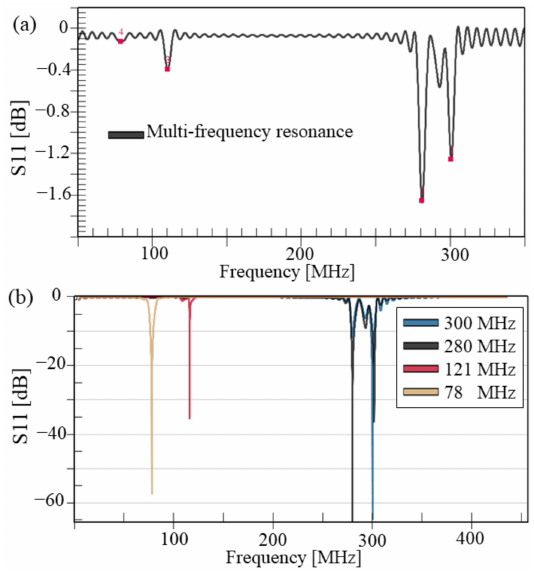
Figure 6. The S11 parameters of the proposed microstrip arrangement, showing the respective resonance frequencies, ( a ) before matching circuit, and ( b ) after using matching circuit.